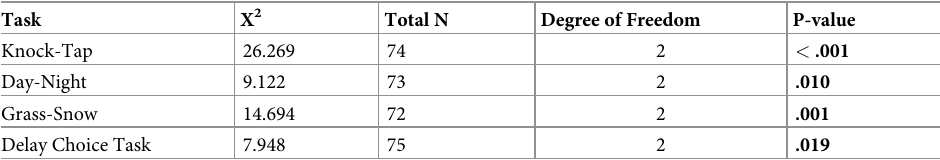
Table 3. Age effect on inhibitory control and delay choice tasks. Task